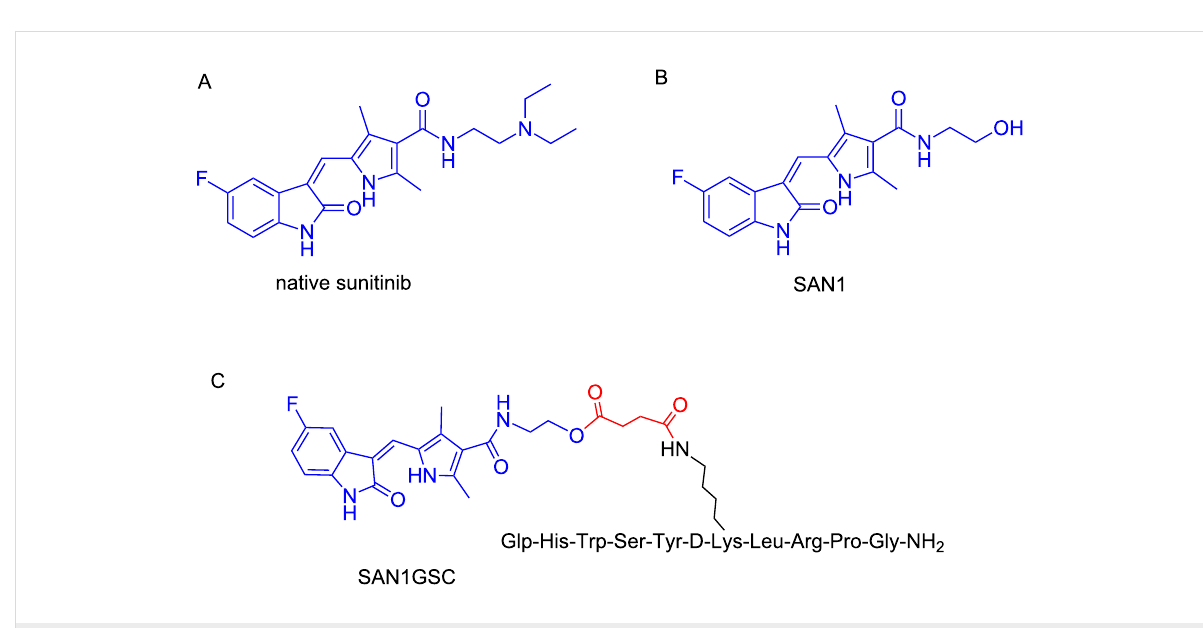
Figure 12: Structures of (A) native sunitinib; (B) SAN1 analog of sunitinib and (C) assembled PDC named SAN1GSC [18].